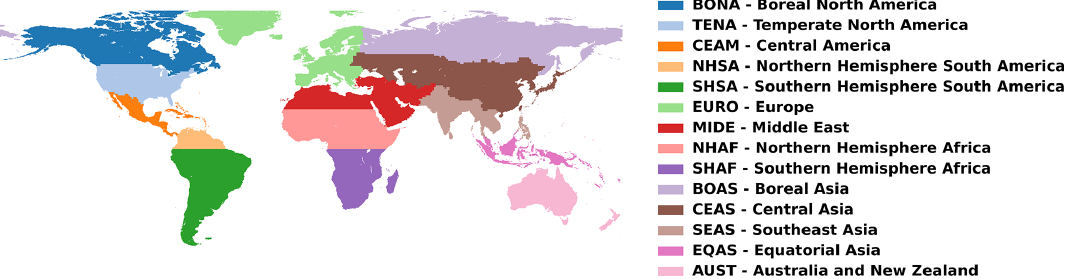
Figure 2. Basis regions, as defined in the GFED4s dataset (Giglio et al., 2013).